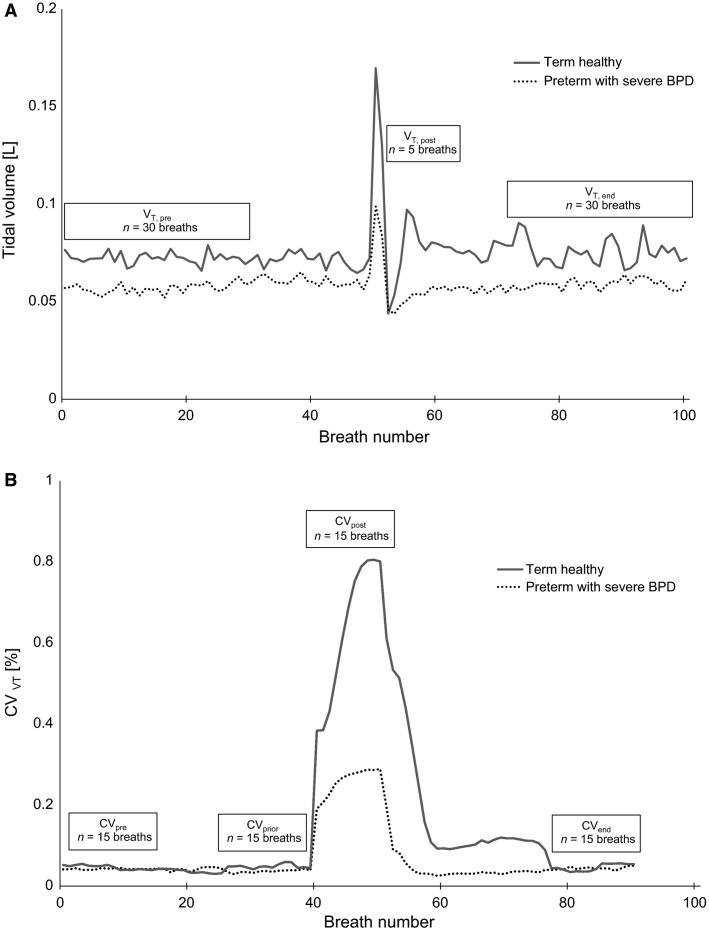
Representative tidal breathing traces of VT (A) and coefficient of variation in VT (CVVT) (B) for an infant with severe bronchopulmonary dysplasia (BPD) and a term healthy control infant. VT,pre, mean tidal volume over the first 30 breaths of the measurement; VT,post, mean tidal volume over the first five breaths after the sigh; VT,end, mean tidal volume over the last 30 breaths of the measurement; CVpre, CVpost, and CVend, coefficient of variation in VT,pre, VT,post, and VT,end, respectively; CVprior, coefficient ofvariation in VT over 15 breaths preceding a sigh.